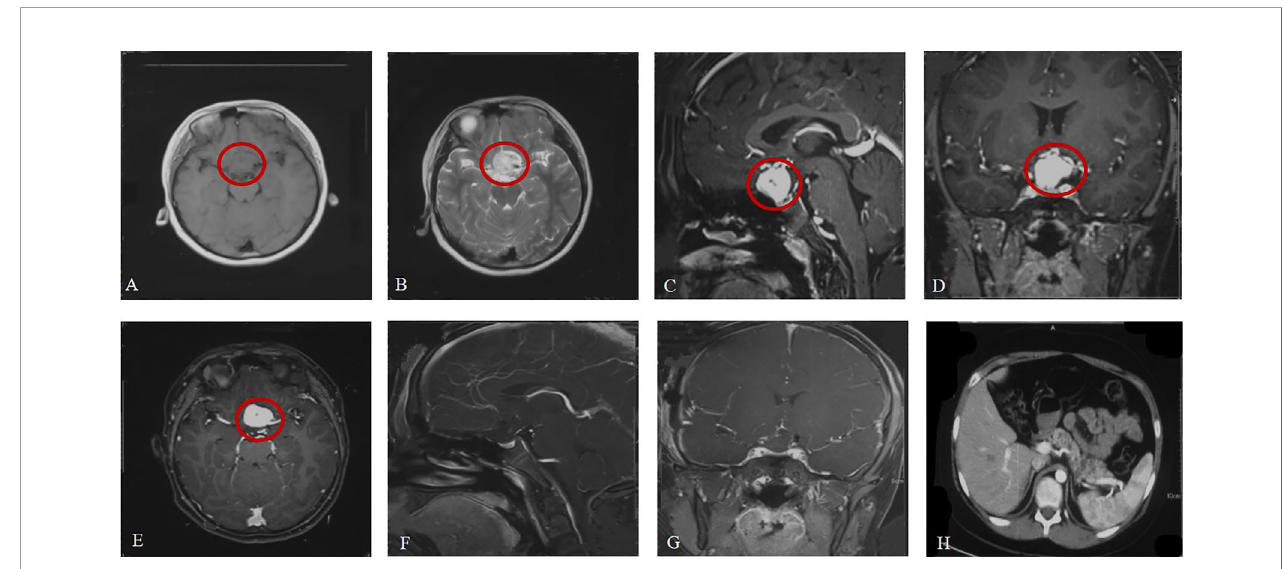
FIGURE 1 | Brain MRI at admission (A – E) . (A, B) Axial view (weighted sequence in T1, T2). (C – E) Sagittal, coronal, axial view after contrast injection, with the tumor marked. (F, G) Brain MRI after surgery. (H) Pancreatic